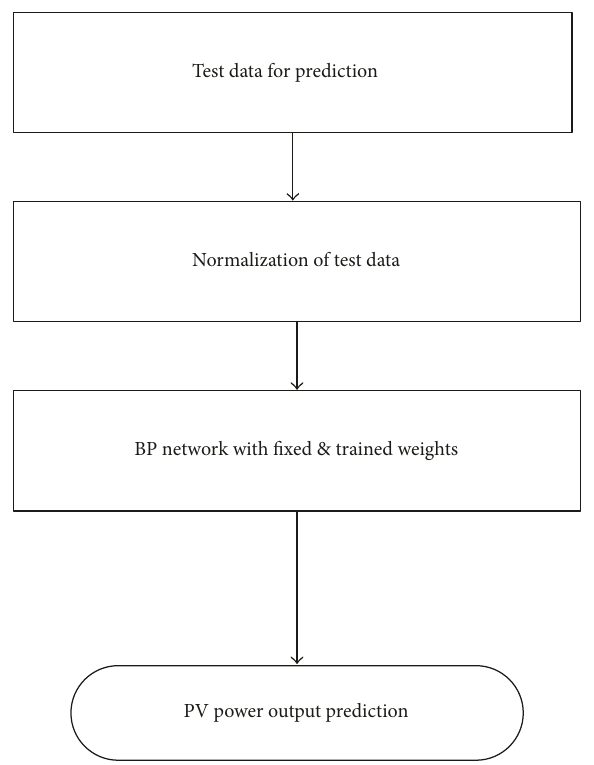
Figure 4: Prediction of PV power by trained